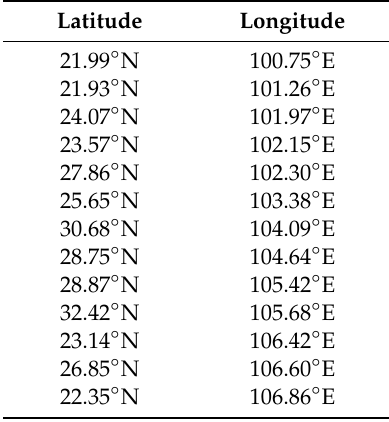
Table A1. The occurrence data for